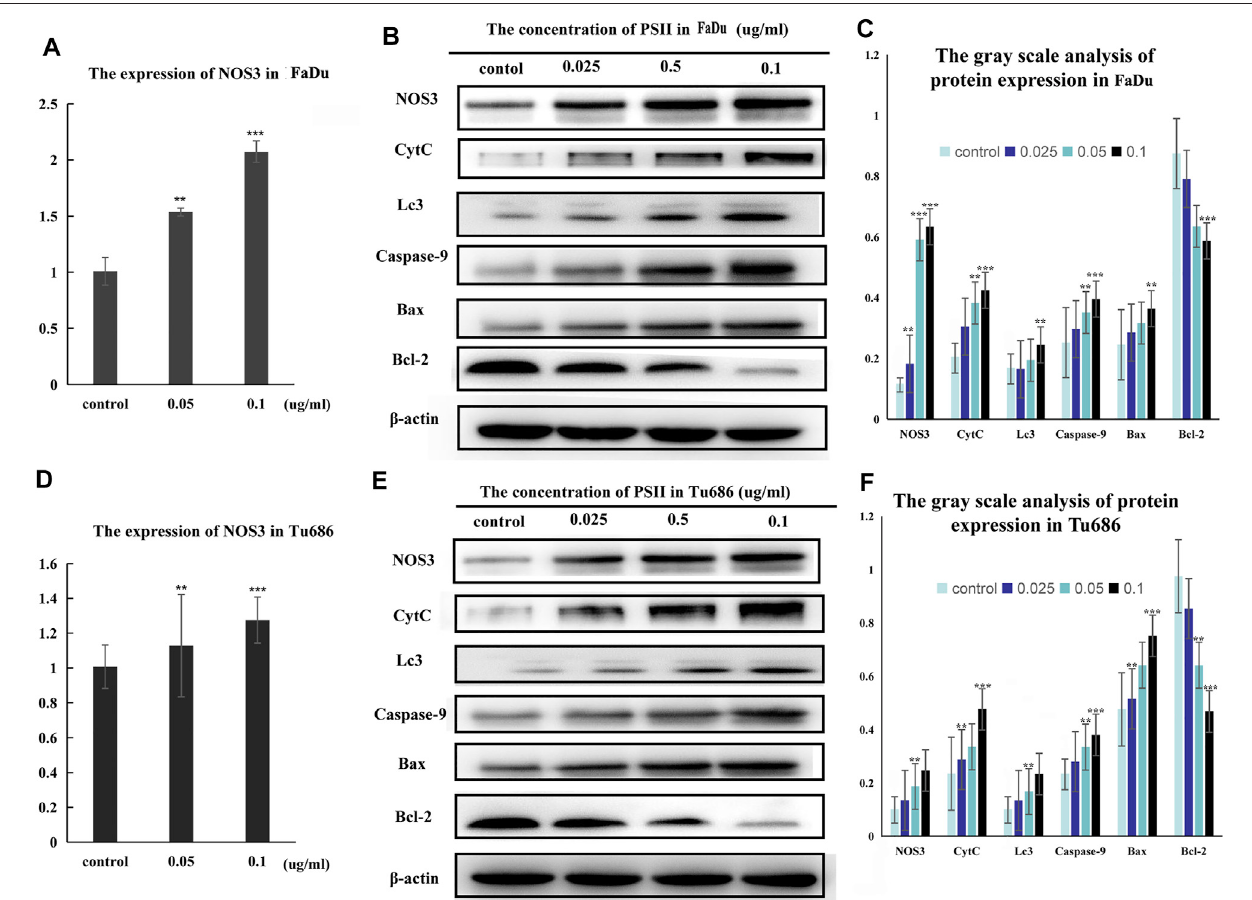
FIGURE 8 | Signal pathway inducted by PSII in HNSCC cells. (A) The mRNA expression of NOS3 in FaDu cells by RT-PCR assay. (B) PSII treatment induced apoptosis and autophagy by mitochondrial pathway (NOS3, CytC, Lc3, caspase-9, Bax, and Bcl-2) in FaDu cells. (C) The gray scale analysis of protein expression in FaDu cellsby Western blot. (D) The expression ofNOS3 mRNA inTu686 cells byRT-PCR assay. (E) PSII treatment inducedapoptosis and autophagy by mitochondrial pathway (NOS3, CytC, Lc3, caspase-9, Bax, and Bcl-2) in Tu686 cells. (F) The gray scale analysis of protein expression in Tu686 cells by Western blot. We used β -actin as control. All the experiments were carried out three times. Each data represent the mean ± SD of three independent experiments (* p < 0.05; ** p < 0.01; *** p < 0.001 vs the control group).